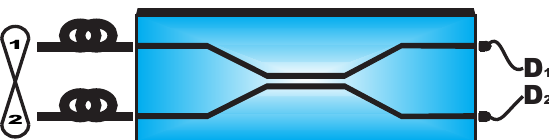
Figure 8. Integrated detection system. The device is made up of a 3 dB DC and two PNRDs. The difference of the number of photons recorded at each output D 1 and D 2 gives information about the order and handedness of the input quantum vortex